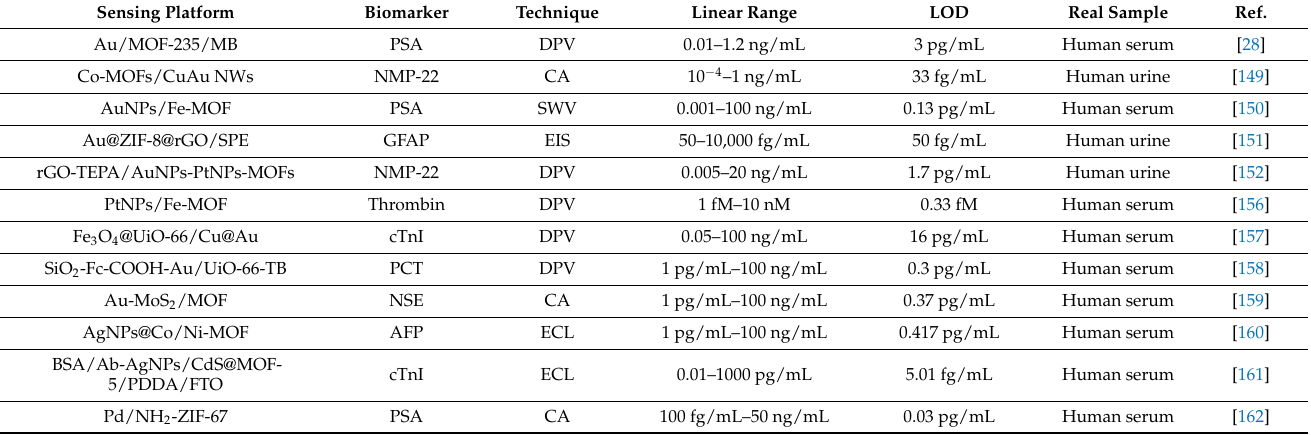
Figure 19. ( A ) Various literature reported conditions and approaches for the synthesis of MOFs. Reprinted with permission from Ref. [153]. Copyright 2021, Elsevier. ( B ) Structures of porous MOFs reported by several research groups. Reprinted with permission from Ref. [154]. Copyright 2015, Royal Society of Chemistry. ( C ) Various biomedical applications of 2D MOFs. Reprinted with permission from Ref. [155]. Copyright 2022, BMC (Springer). Table 4. Recent literature reports on metal nanoparticles incorporated MOFs for electrochemical biomarker detection. Real Sample